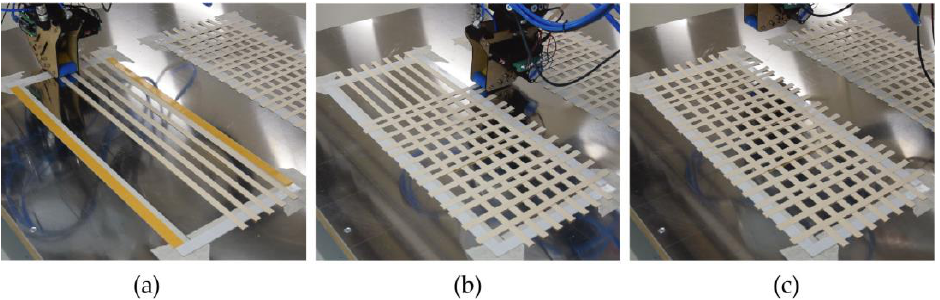
Figure 2. Robotic fiber laying process: ( a ) Fiber laying in direction one; ( b ) Fiber laying in direction two; ( c ) Completed 2D lattice.